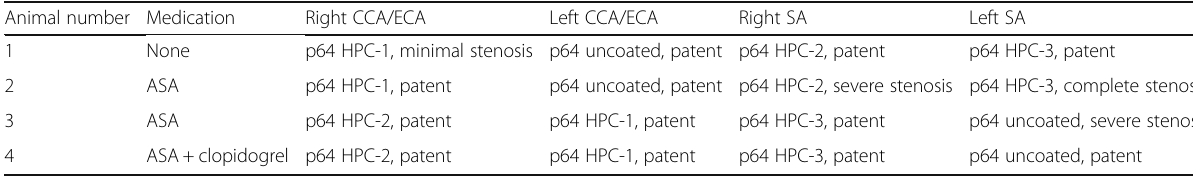
Table 4 Summary of the delayed post-procedural (day 28) angiography results Animal number Medication